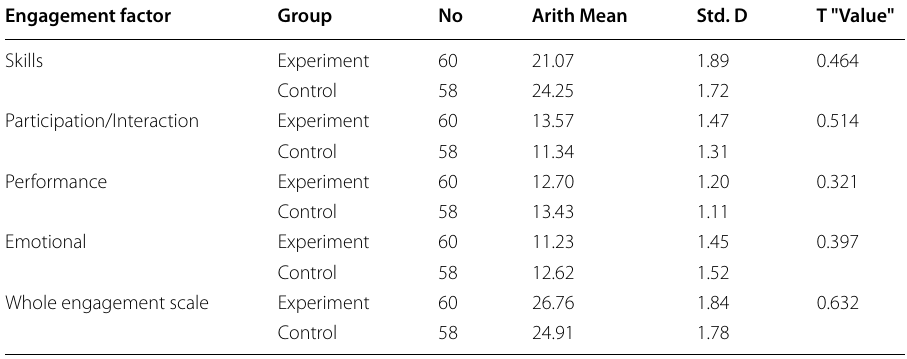
Table 3 Entry‑level of both experimental and control groups in students’ scores on skills, participation, performance, emotional, and overall score for the pre‑test "students’